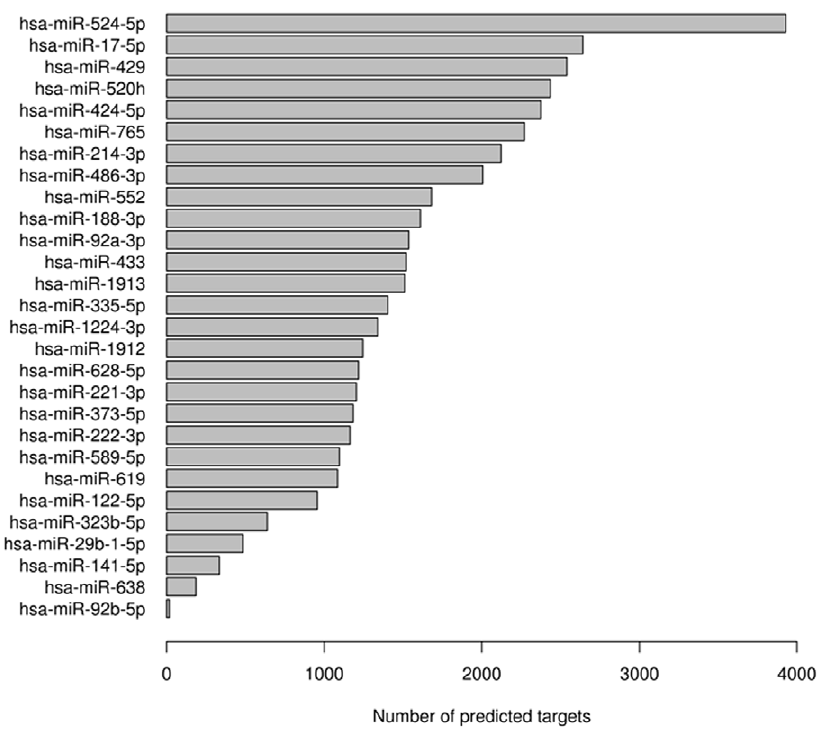
Figure 4. Distribution of the number of mRNAs targeted by differentially regulated microRNAs in diabetic urine. doi:10.1371/journal.pone.0054662.g004 PLOS ONE |